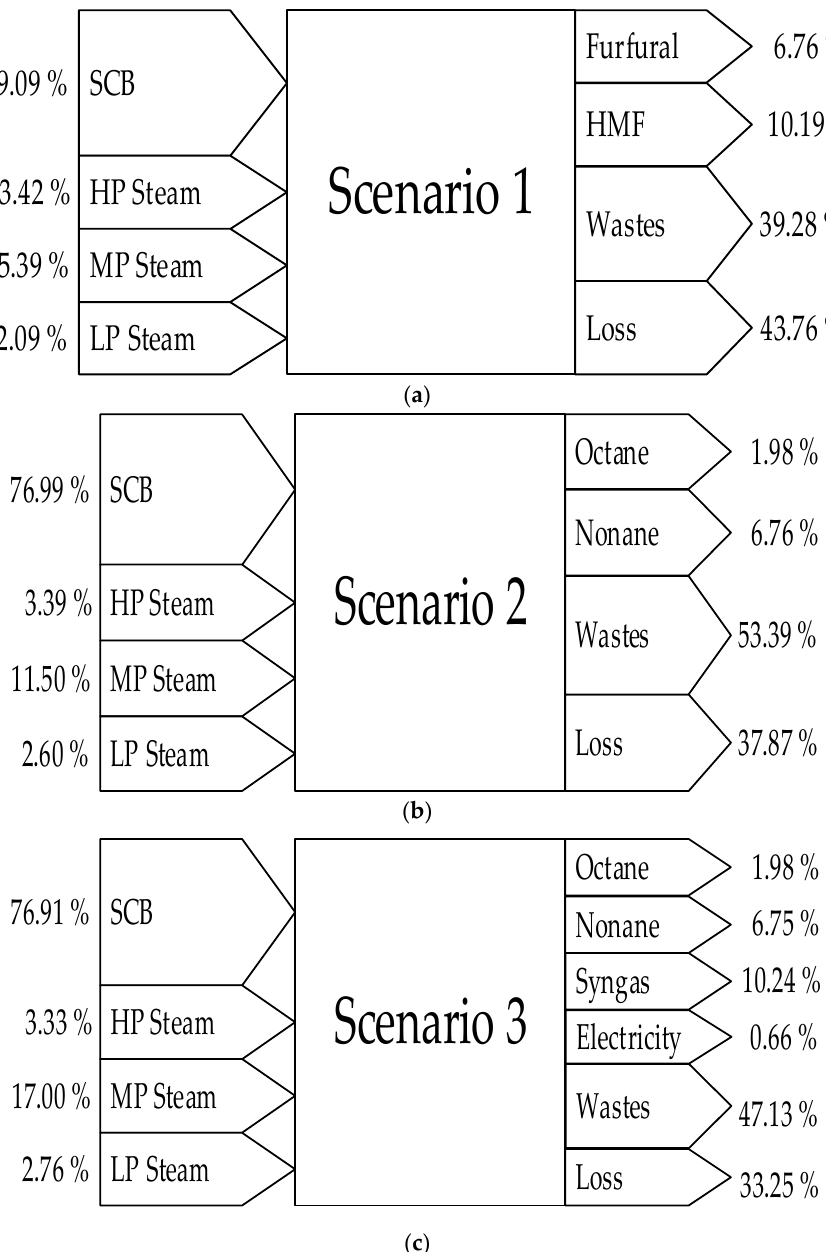
Figure 2. Sankey diagrams for the energy distribution of scenarios 1, 2, and 3. (a) Energy distribution in the scenario 1; (b) Energy distribution in the scenario 2; (c) Energy distribution in the scenario 3.